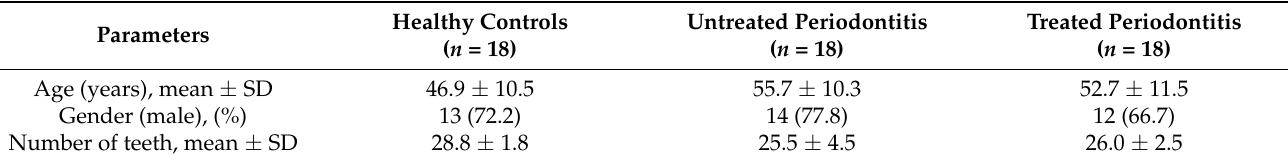
Table 1. Demographic and clinical characteristics of the experimental